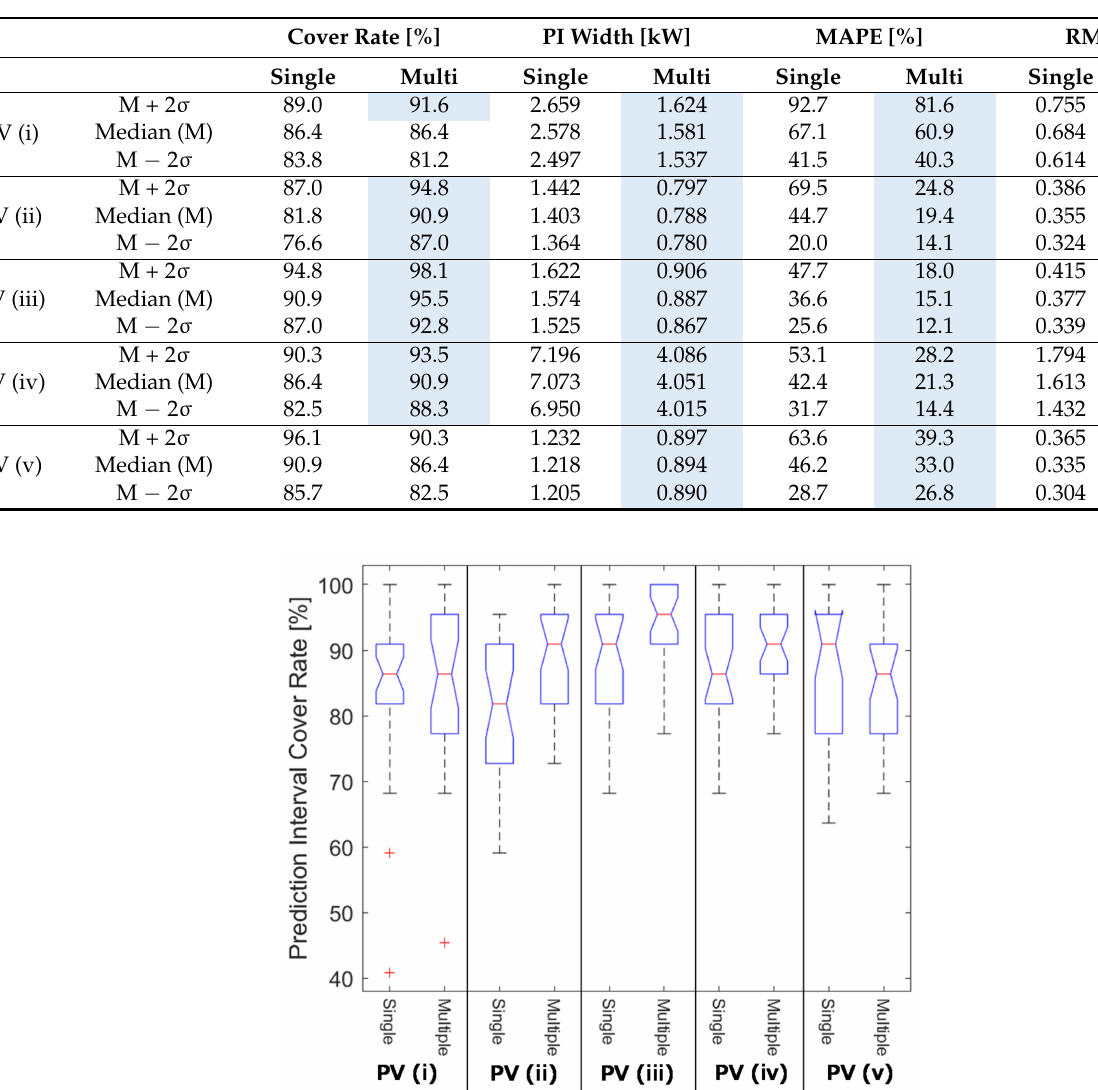
Table 2. Summary of the multiple PVs forecast for 30 days.